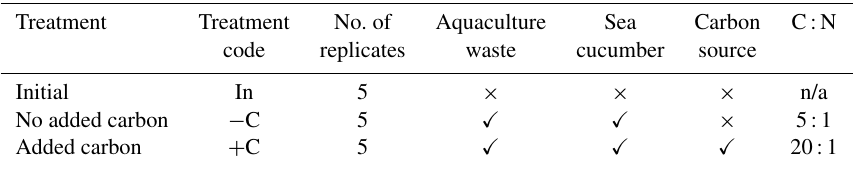
Table 1. Description of the experimental treatments. The presence ( (cid:88) ) or absence ( × ) from day 0 of aquaculture waste, added carbon source or sea cucumbers is indicated. Treatment Treatment No. of Aquaculture Sea Carbon C:N code replicates waste cucumber source Initial